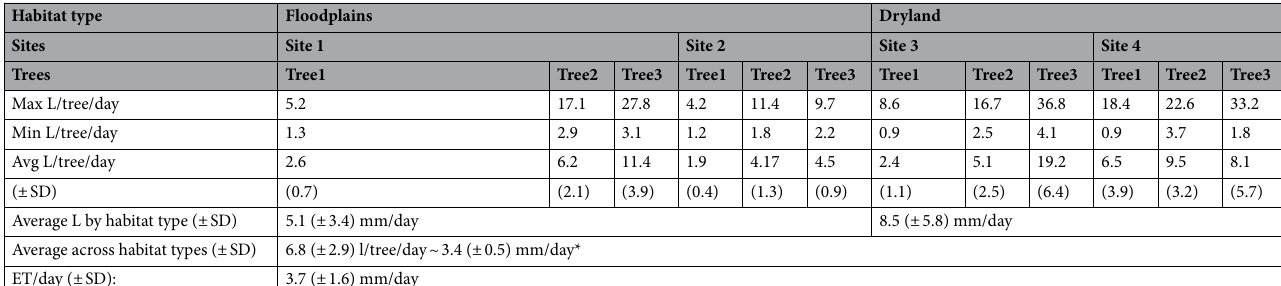
Table 1. Daily transpiration dynamics of the instrumented Prosopis trees in the floodplains and in the dryland of the Awash River Basin for the period January to November 2017. * Canopy cover area of Prosopis trees was estimated to be on average 2 m 2 .